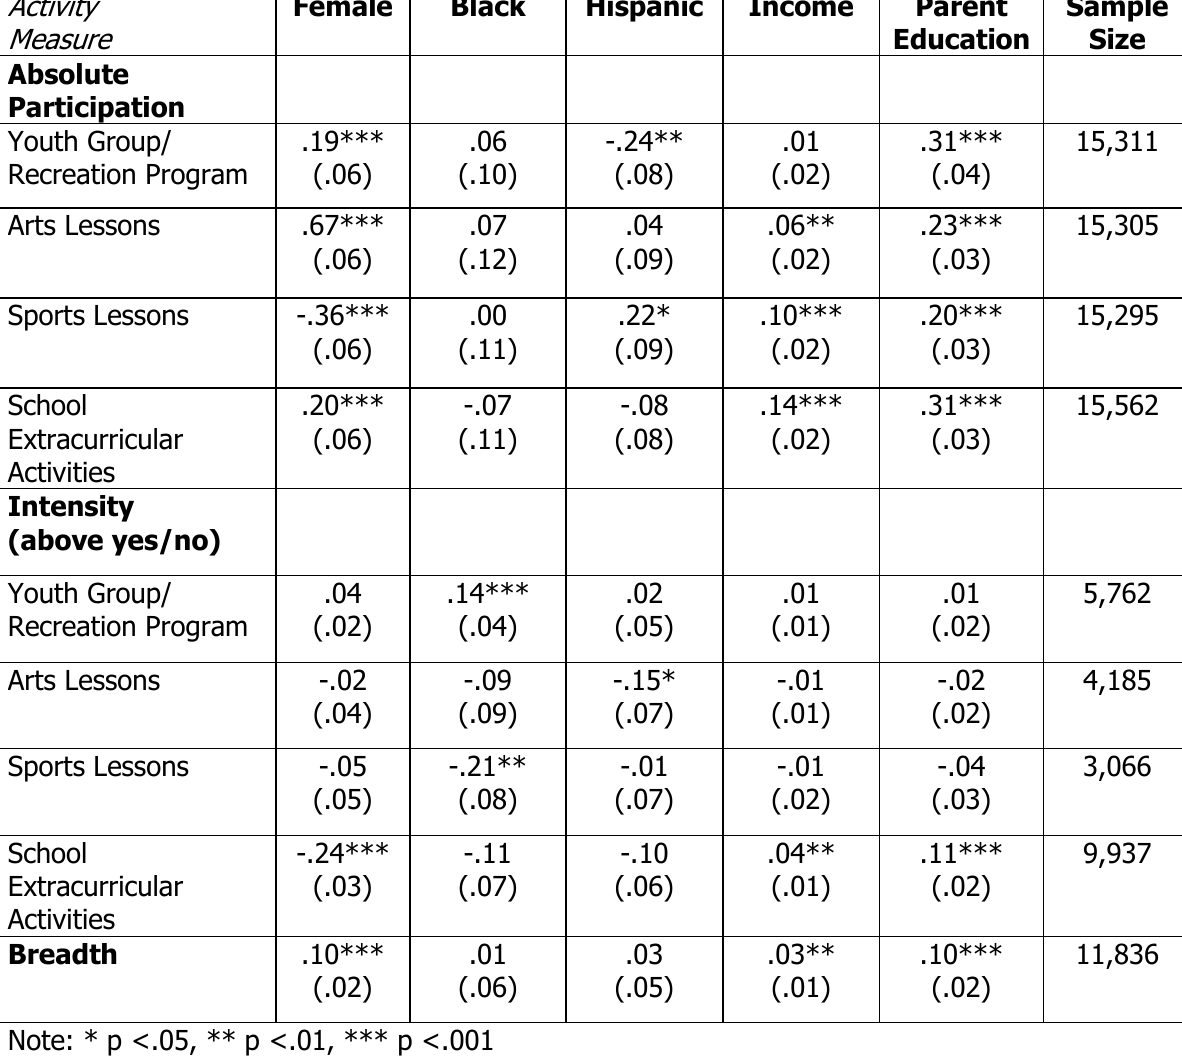
Unstandardized Regression Coefficients (Standard Error) of Demographic Characteristics Associated with 10 th grade OST Participation in